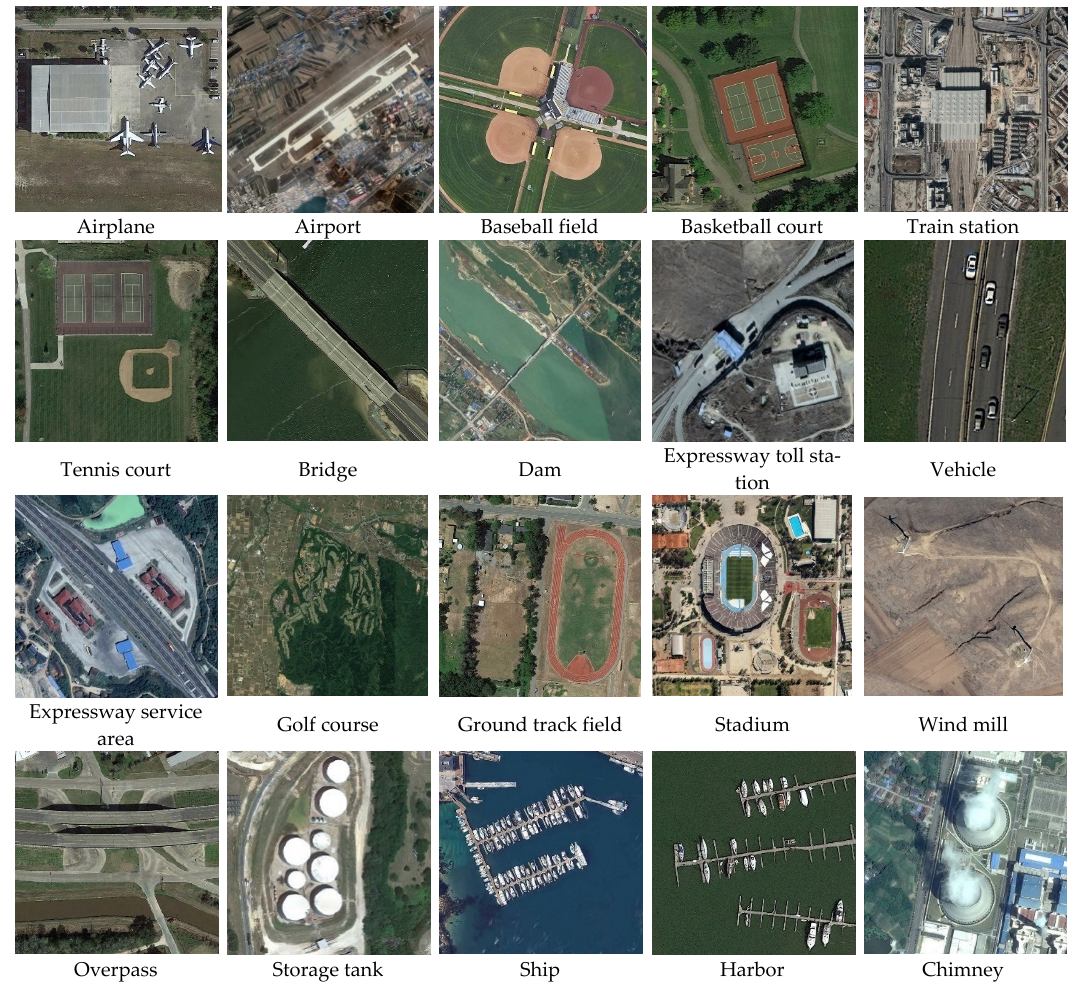
Figure 6. Example of DIOR dataset.